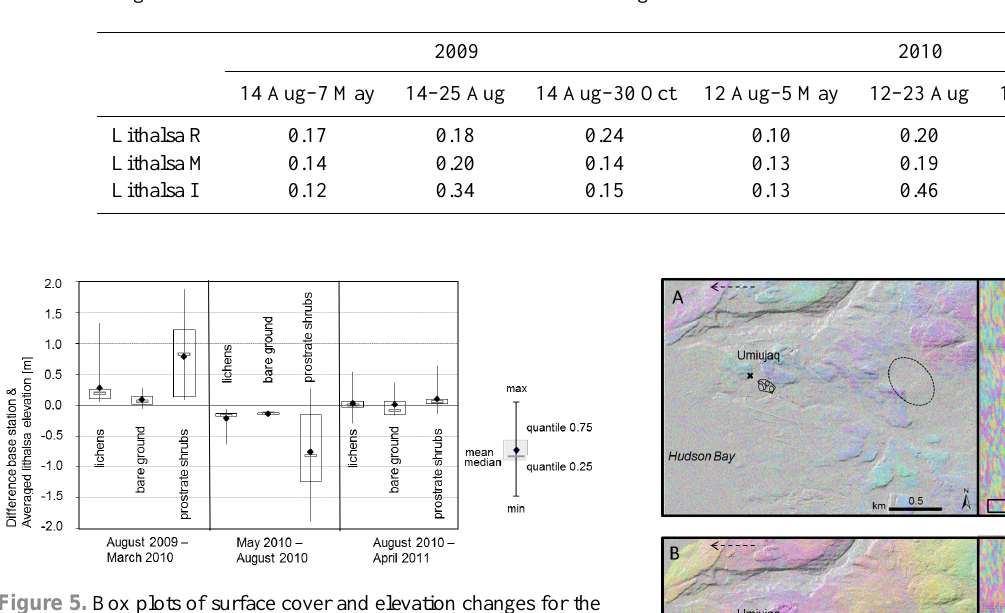
Table 4. Average coherence over the three lithalsas for the six interferograms.